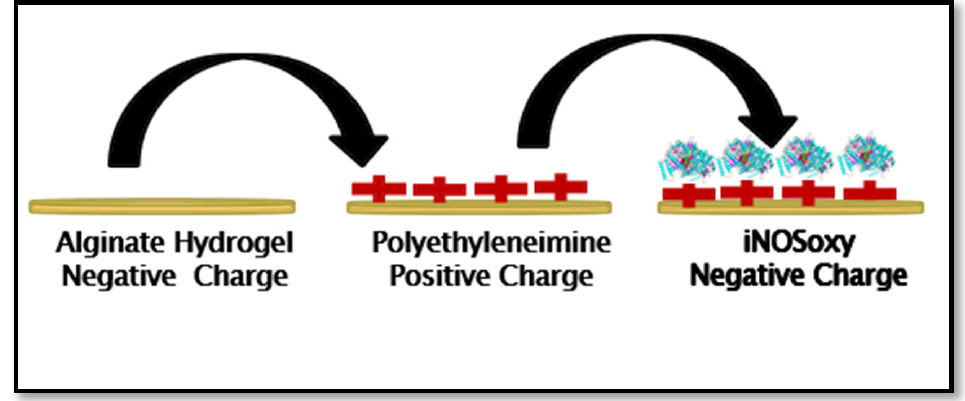
Figure 11. Preparation of SA/PEI//iNOSoxy hydrogel using crosslinking of the first layer of SA with PEI followed by additional layers of PEI/iNOSoxy.